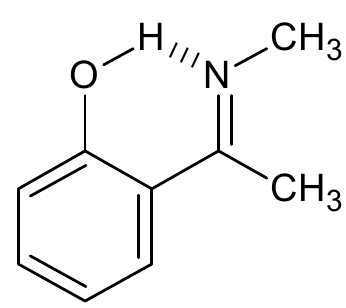
Figure 3. The structure of 2-((1-methylo-imino)ethyl)phenol.